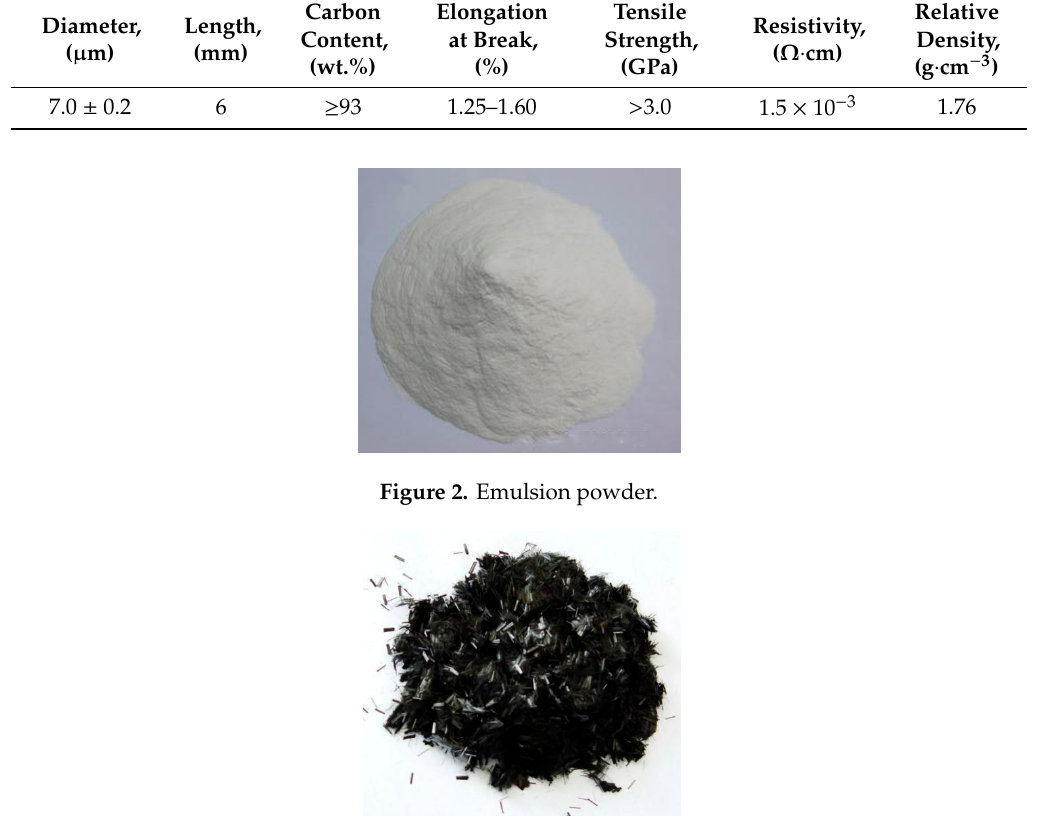
Figure 3. Short-cut carbon fibers.